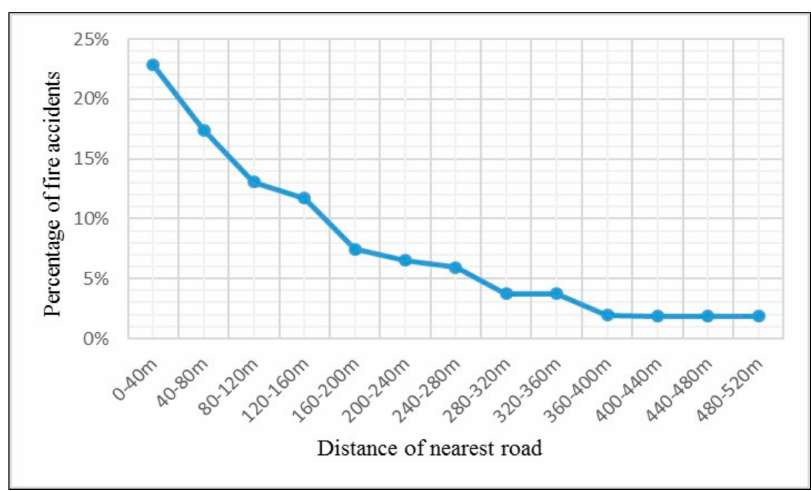
Figure 5. The distance from the fire location to the nearest road.